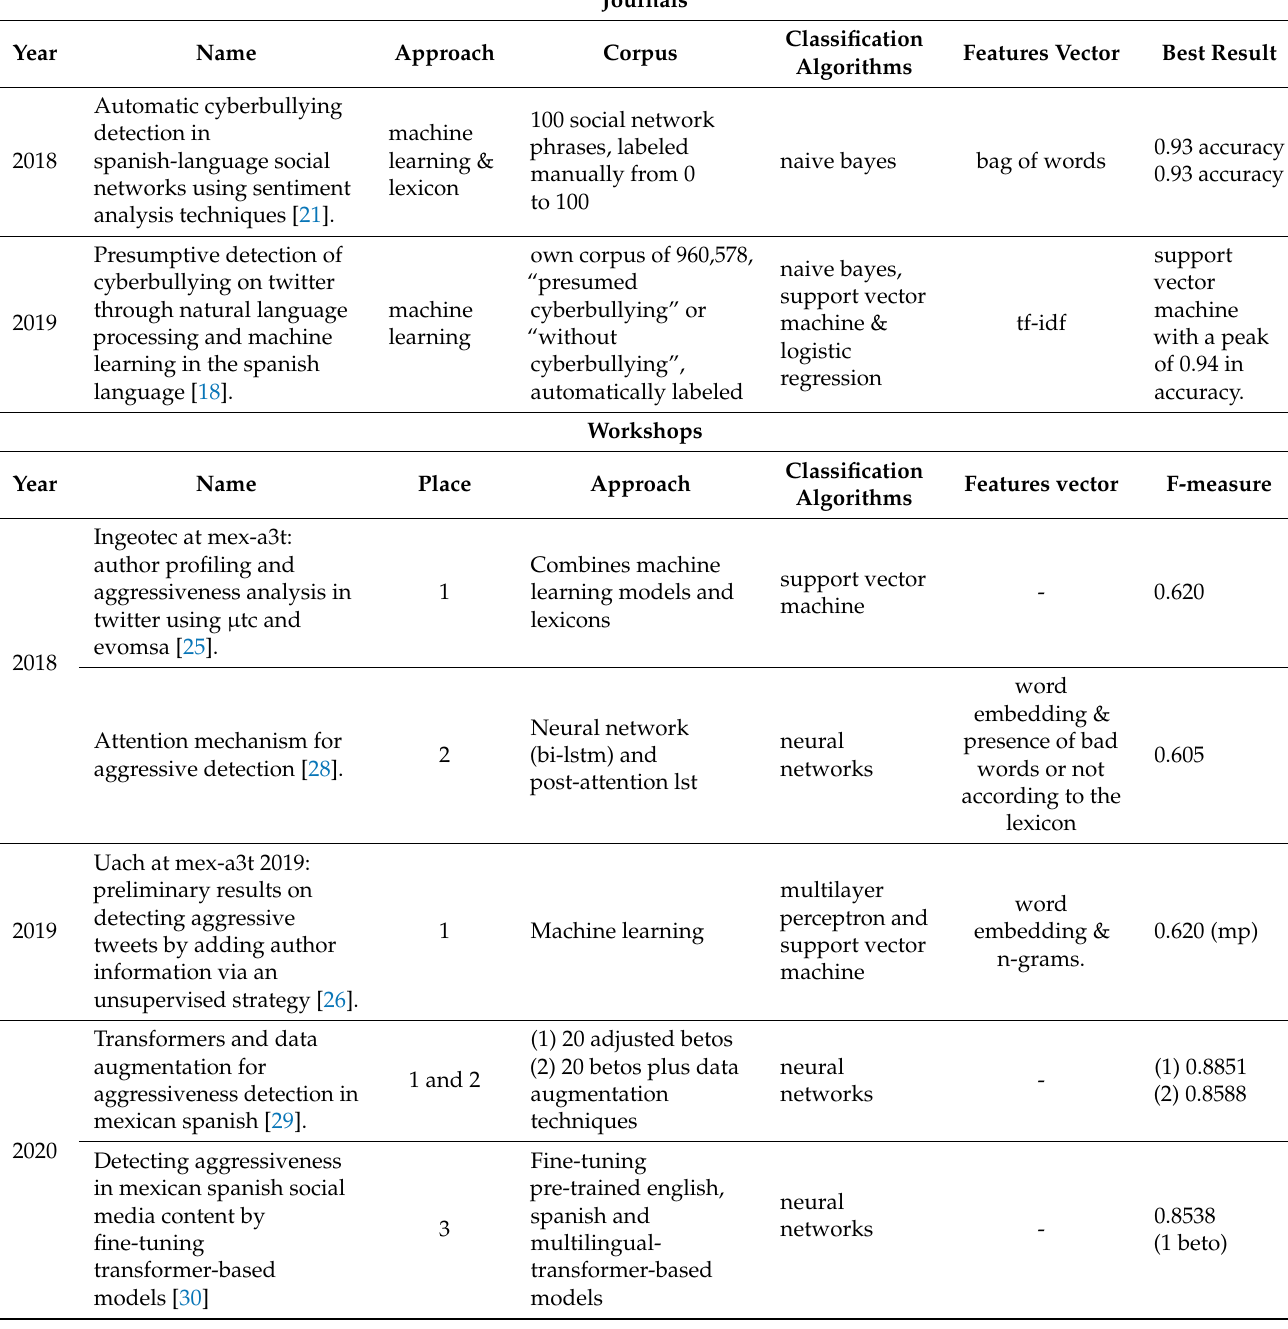
Table 2. Summary of aggressive detection models